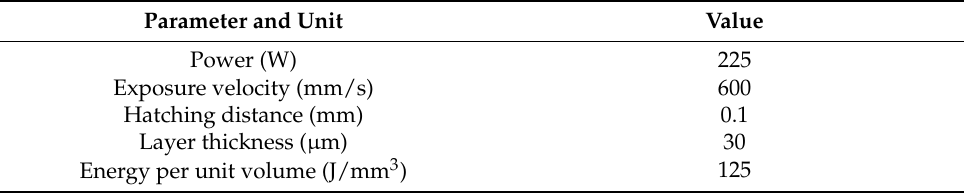
Figure 12. Columnar chart showing porosity in two planes of each tested parameter group. Based on an analysis of the specimen structure manufactured with different parameters, a group of those that provided the lowest porosity was selected. Their values are shown in Table 3. Table 3. Printing parameters used to manufacture cellular